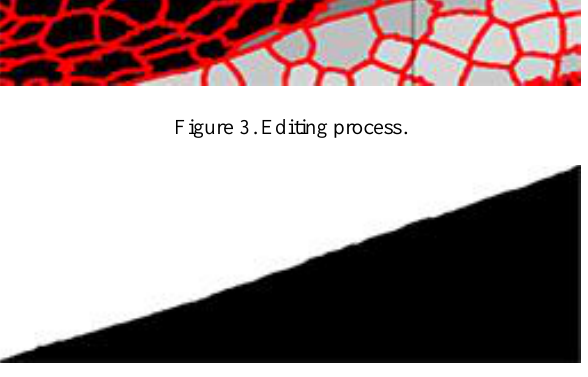
Figure 4. Resulted binary